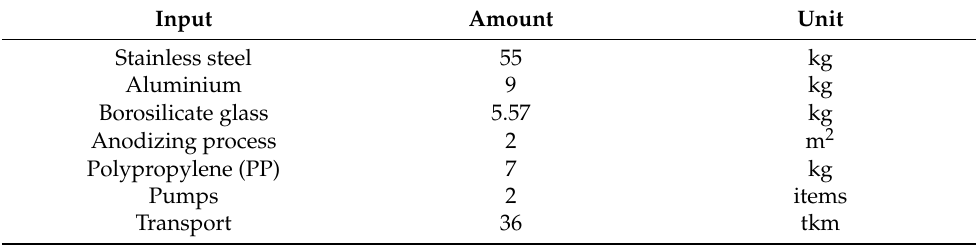
Figure 1. A photo of the pilot plant. The plant consists of two borosilicate tubes (diameter 50 mm, thickness 2.5 mm), through which the solution to be treated flows. Two aluminium parabolic mirrors concen- trate the sunlight in the axis of each tube. The total surface of the photoreactor is 0.45 m 2 , with an irradiated volume of 4.5 L. The surface is tilted 40 ◦ with the horizon and left in a sunny place with a southern orientation. The solution is circulated inside the reactor by means of a pump. The reactor is equipped with a radiometer (Acadus 85-PLS), which mea- sured the received UV-A radiation; the radiometer contribution, however, was neglected in LCA modelling. The inventory data relative to the pilot plant are reported in Table 4. Table 4. Inventory data for the pilot